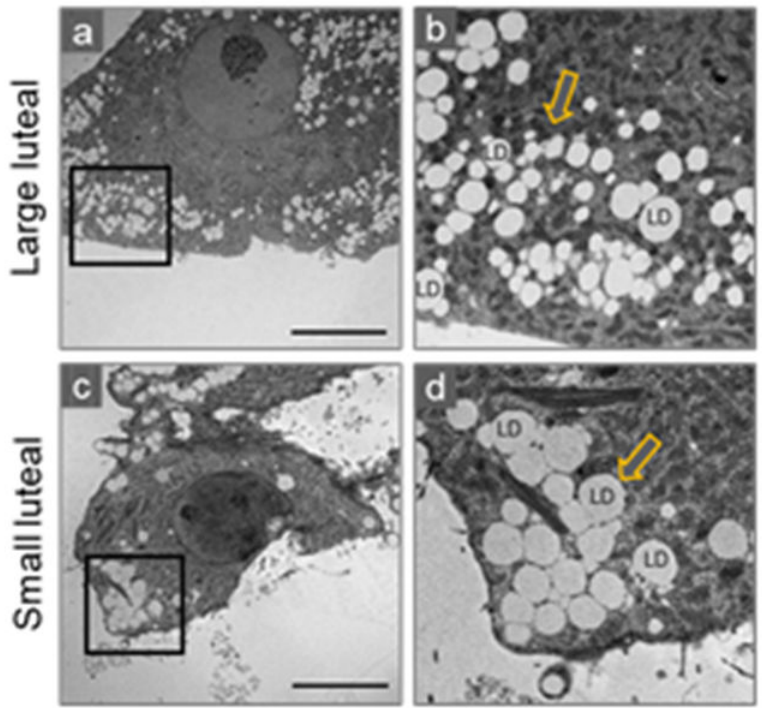
Figure 2. Distribution of lipid droplets in steroidogenic large and small bovine luteal cells. Trans- mission electron microscopy was employed to visualize intracellular lipid droplets (LD) in cultured bovine luteal cells. Representative micrograms of large ( a , b ) and small ( c , d ) luteal cells. Black box represents enlarged area ( b , d ). Arrows indicating LDs. Micron bar represents 10 µ